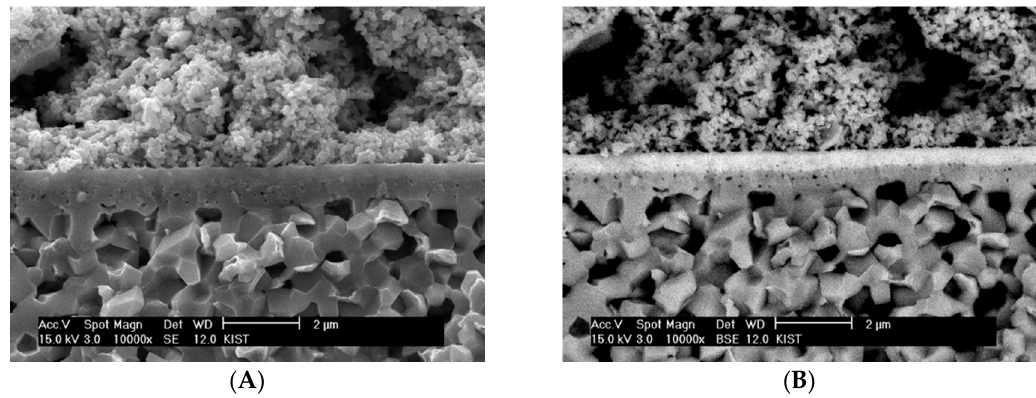
Figure 8. SEM images of the bi-layer electrolyte fabricated by chemical solution deposition route collected in ( A ) secondary electron and ( B ) back-scattered electron modes.